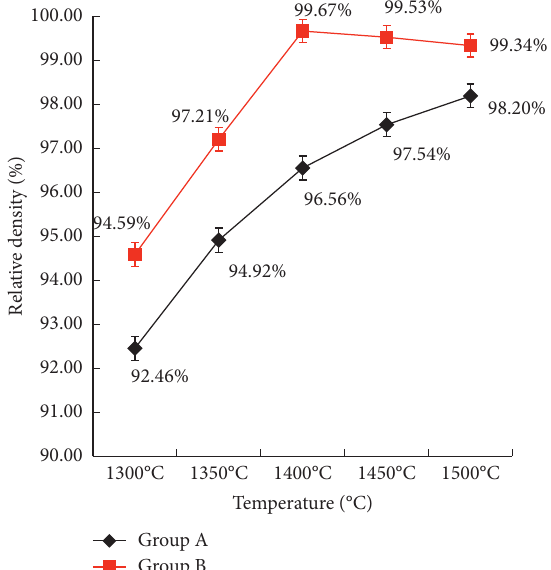
Figure 13: Relative density of samples at different microwave sintering temperatures.